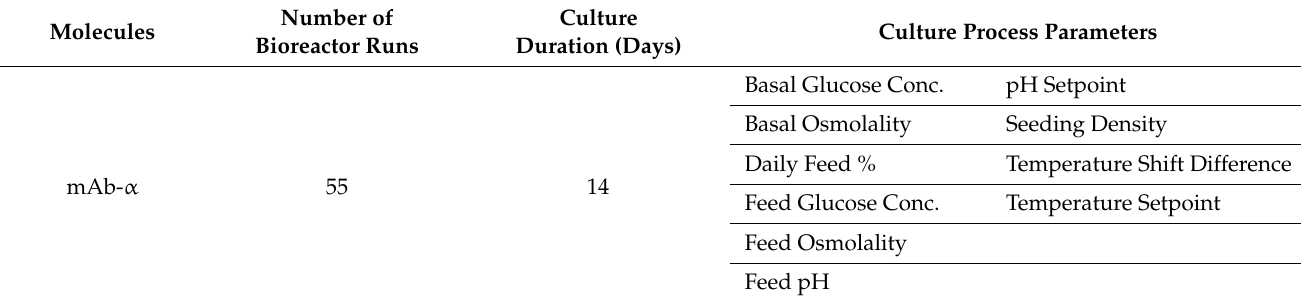
Table 1. Dataset details for each of the mAbs considered within this study (conc. means concentration, supp. means